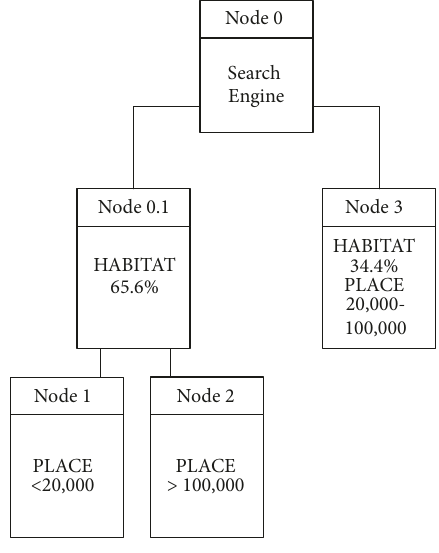
Figure 2: CHAID decision tree.